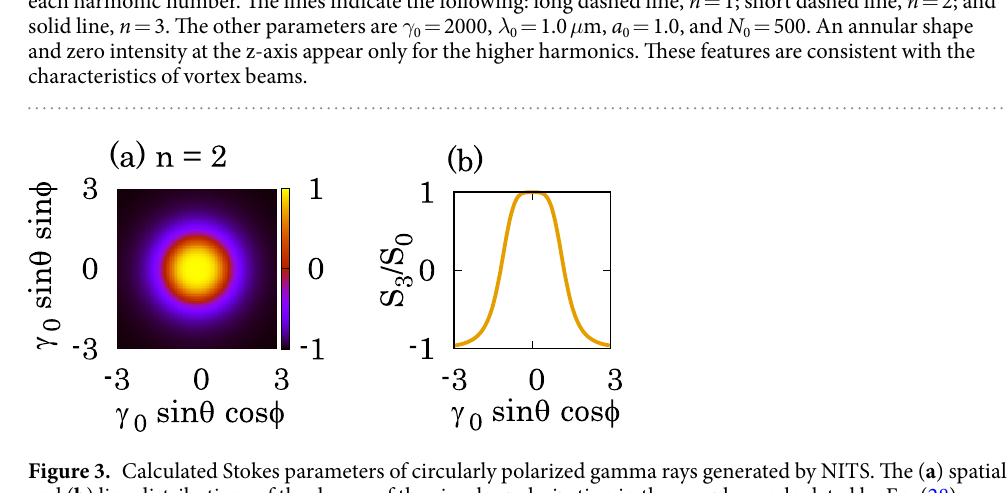
Figure 3. Calculated Stokes parameters of circularly polarized gamma rays generated by NITS. The ( a ) spatial and ( b ) line distributions of the degree of the circular polarization in the x–y plane calculated by Eq. (28). The parameters are γ 0 = 2000, λ 0 = 1.0 μ m, a 0 = 1.0, N 0 = 500, and n = 2. S 3 / S 0 = 1( − 1) means 100% circular polarization with positive (negative) helicity. In the scattering angle of θ < 0.6/ γ 0 and 2.40/ γ 0 < θ , the degree of the circular polarization of the gamma-rays are more than 90% circular polarization with positive and negative helicity,